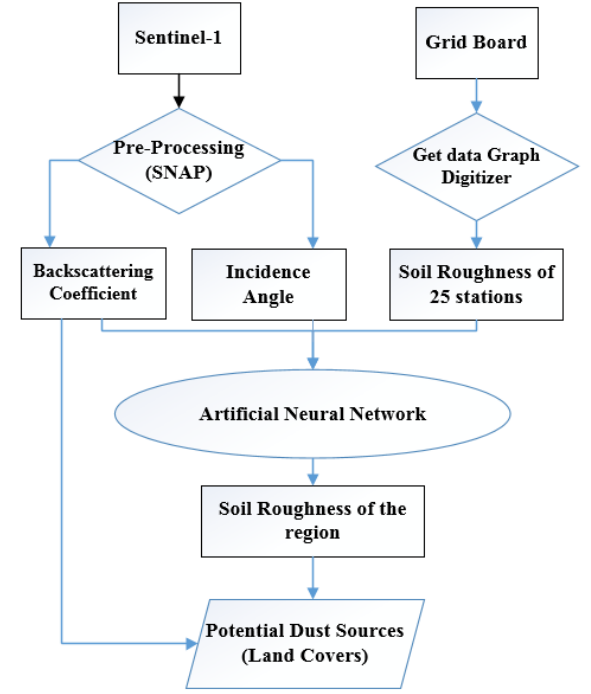
Figure 2. The flowchart of proposed